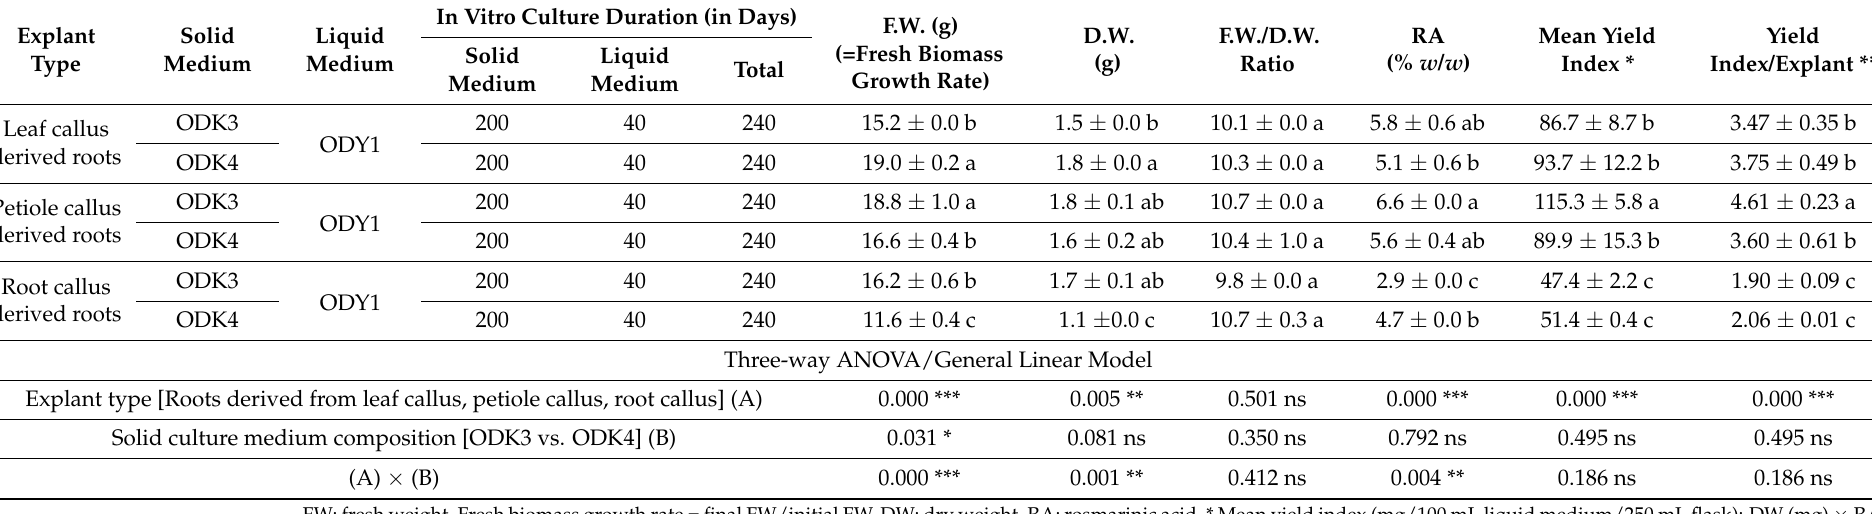
Table 4. Effect of three explant types (leaf, petiole and root callus derived roots) and initial agar solidified media composition under 240 days of total